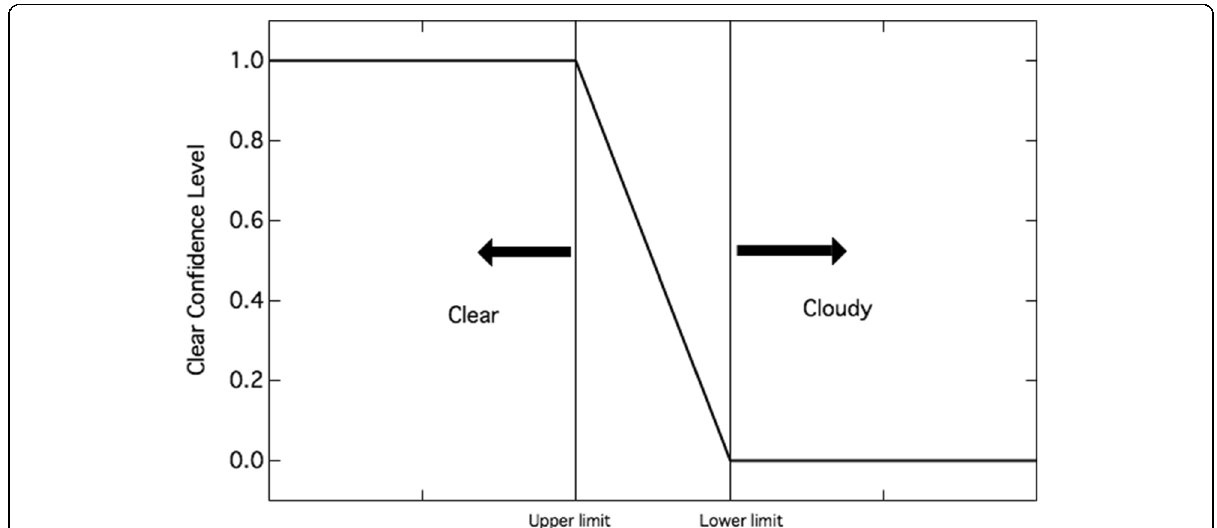
Fig. 2 Determining the CCL in the cloud discrimination process. The horizontal axis represents the values for the threshold test. In this case, the observed value is large when clouds are present. Two threshold values, the lower limit and upper limit, are set, creating an ambiguous area between the two limits that is expressed as a CCL from 0 to